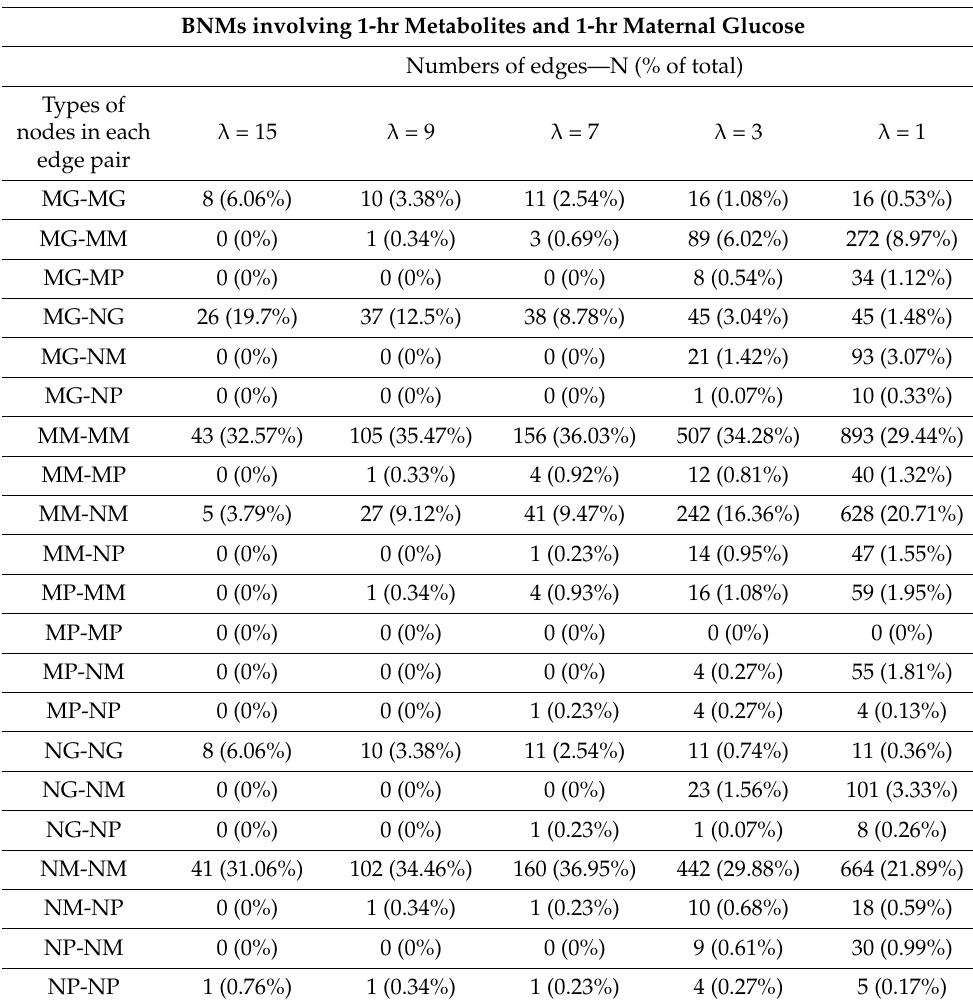
Table 1. Cont. BNMs Involving Fasting Metabolites and Fasting Maternal Glucose BNMs involving 1-hr Metabolites and 1-hr Maternal